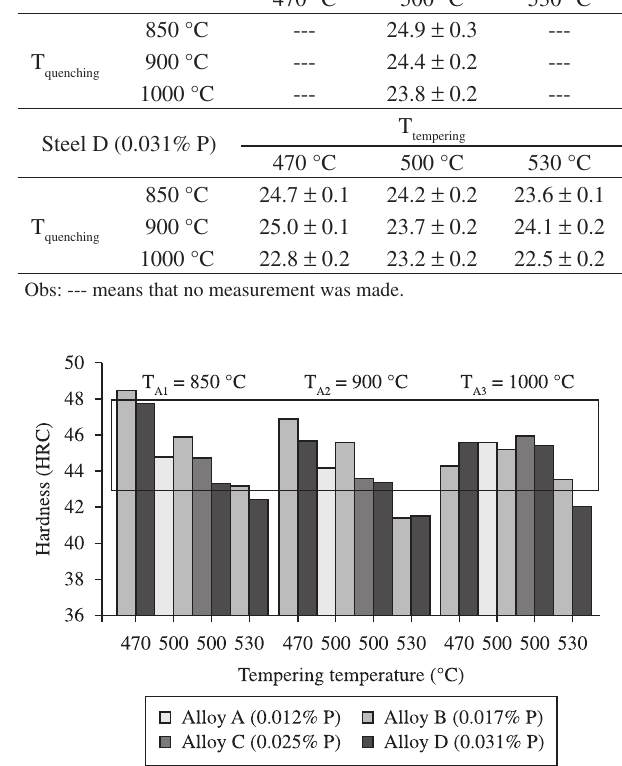
Figure 8. Hardness test results versus tempering temperature for three austenitizing temperatures (TA